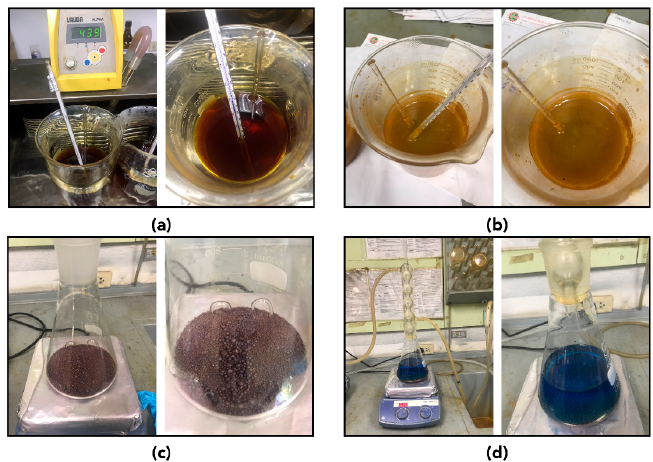
Figure 7. The corrosion tests: ( a ) Pitting corrosion tests under 6% FeCl 3 ·6H 2 O at 50 °C for 0 h; ( b ) Pitting corrosion tests under 6% FeCl 3 ·6H 2 O at 50 °C for 24 h; ( c ) Intergranular corrosion tests under CuSO 4 ·5H 2 O and sulfuric acid at 0 h; ( d ) Intergranular corrosion tests under CuSO 4 ·5H 2 O and sulfuric acid at 24 h.